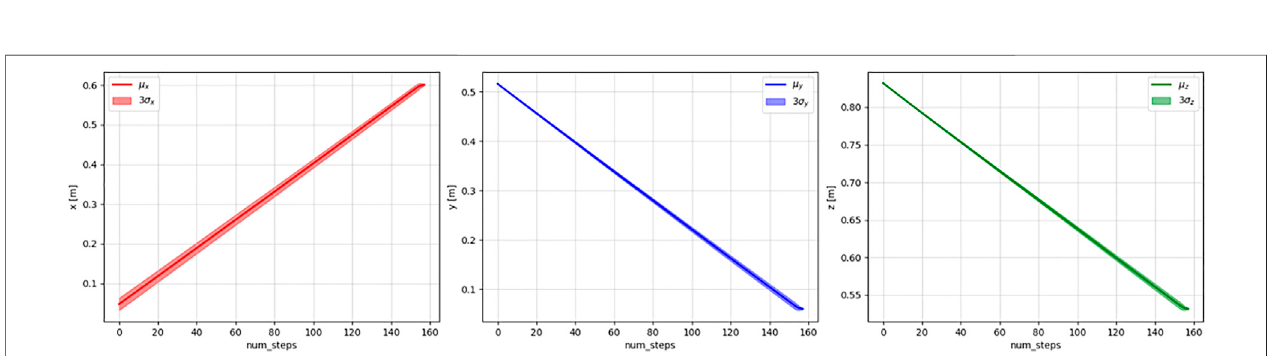
FIGURE 6 | Left, the robot executing one of the demonstrated trajectories for transferring a knife safely to a human. Right: characteristic of the change of the positional (blue) and orientational (green) distance to the goal at different steps of one of the demonstrated paths.